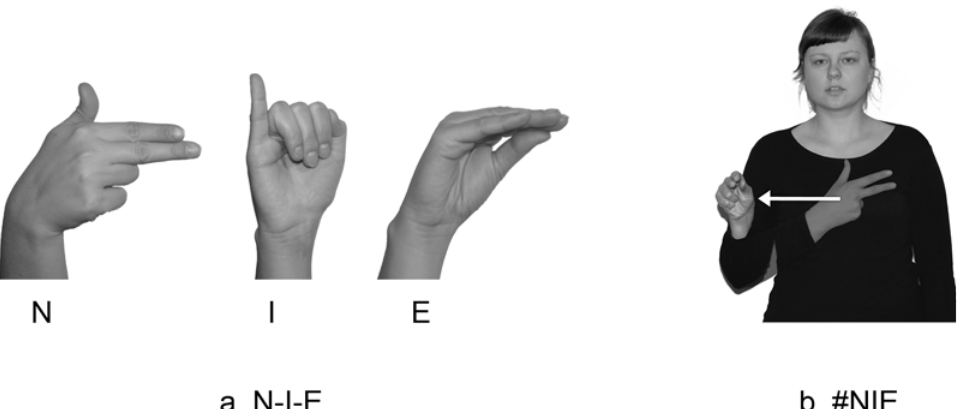
Fig 1. Fingerspelled versions of NIE ‘ no ’ : N-I-E and #NIE. The individual in this figure has given written informed consent (as outlined in PLOS consent form) to publish these case details.